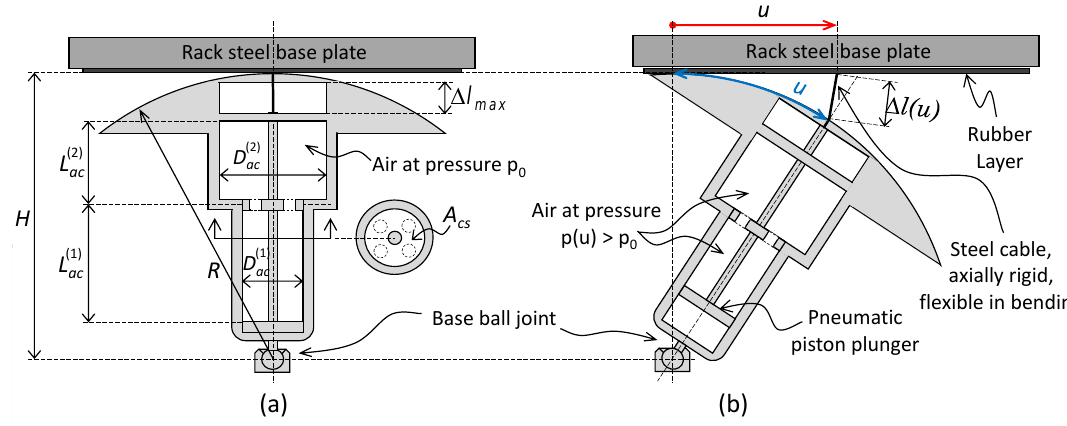
Figure 2. Scheme of the isolator used with a compressed air piston as an elastic element ( a ) static or undeformed equilibrium position, ( b ) deformed position with large lateral displacement.